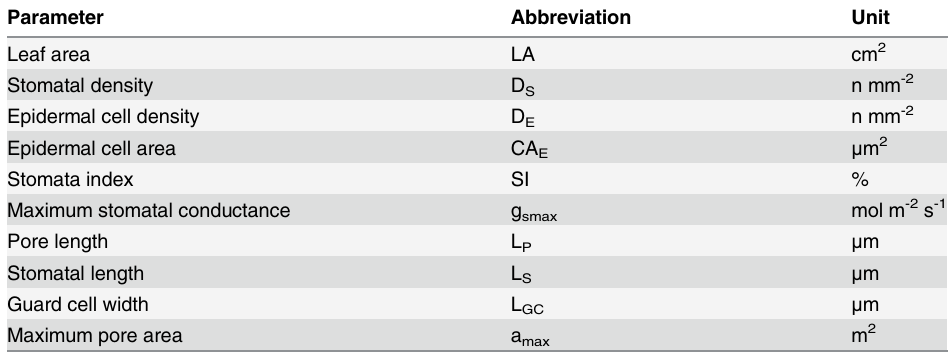
Table 1. Leaf morphological and stomatal parameters. The leaf morphological and stomatal parameters discussed in this paper and their conventional abbreviations and units. Parameter